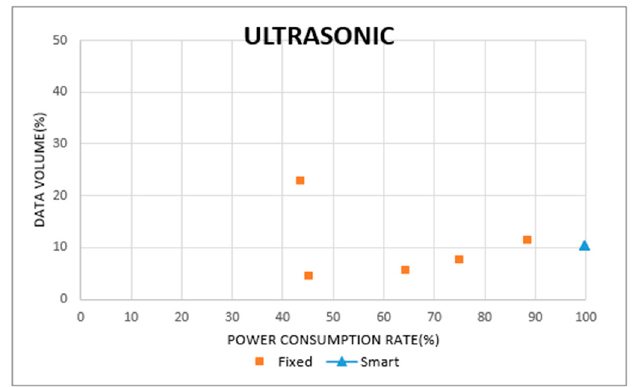
Figure 19. Sensing Data Volume in Ultrasonic Sensor.